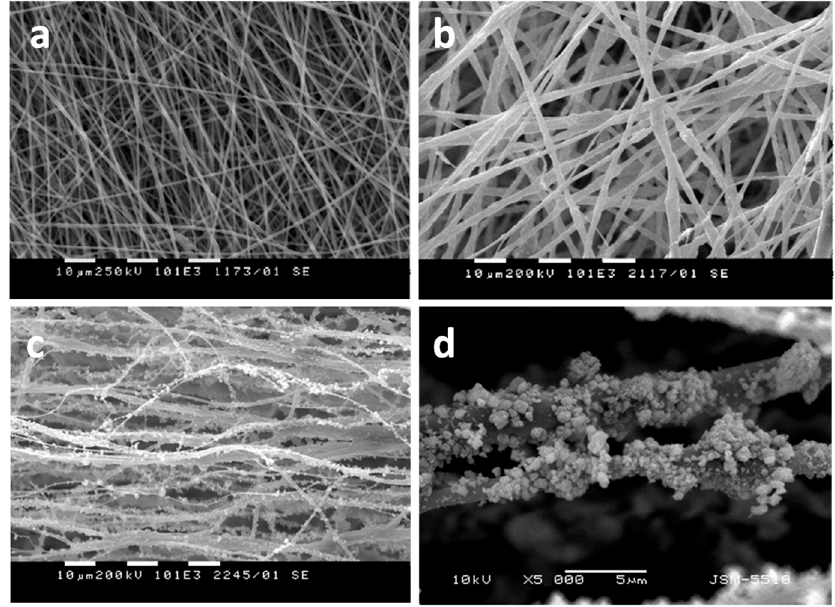
Figure 4. SEM micrographs of fibrous materials: ( a ) PHB (×1000), ( b ) TiO 2 - in -PHB (×1000), ( c ) TiO 2 - on -PHB (×1000), and ( d ) TiO 2 - on -PHB (×5000) [108].